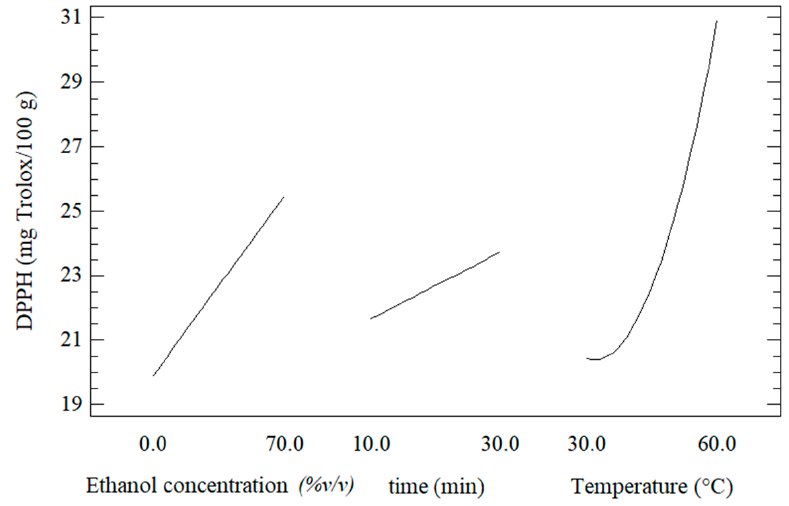
Figure 4. Effect of the individual variables process on the DPPH radical scavenging activity of the extracts of Welsh onion leaves.